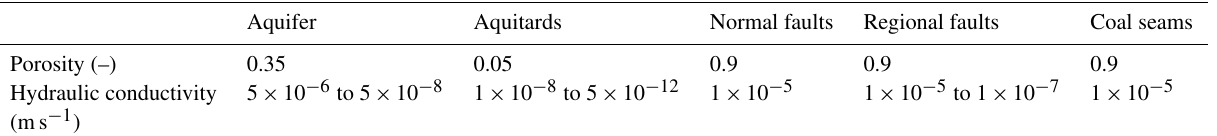
Table 2. Porosities and hydraulic conductivities used for model realisations.